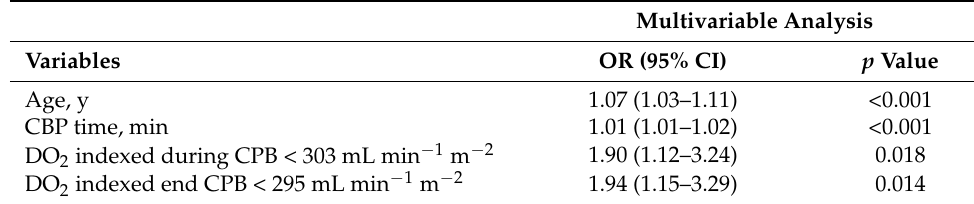
Table 2. Univariate logistic regression analysis for predisposing factors related to Cardiac Surgery- Associated Acute Renal Injury. Table 3. Multivariable logistic regression analysis for Cardiac Surgery-Associated Acute Kidney Injury using DO 2 as a binary categorical variable. N =